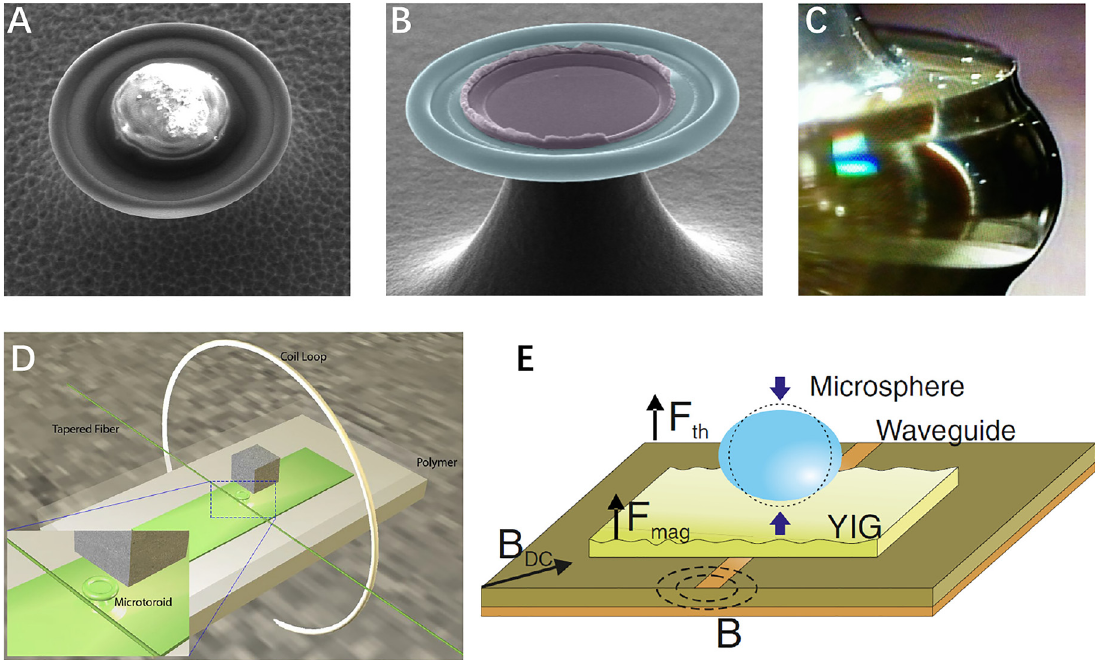
Figure 18: Cavity optomechanical magnetometers. (A) Cavity optomechancial magnetometry using microtoroids with particles of magnetostrictive material Terfenol-D embedded inside [49]. (B) Cavity optomechanical magnetometry using microtoroids with a thin film of Terfenol-D sputter coated inside [47]. (C) Cavity optomechanical magnetometry using a cm-size CaF embedded inside [46]. (D) A magnetometer using a microtoroid with a microsized magnet embedded inside the cavity, capsulated using poly(dimethylsiloxane) (PDMS) [50]. (E) Magnetometry working at hundreds of MHz to a few GHz, assisted by ferromagnetic resonance in a yttrium iron garnet (YIG) film, whose mechanical motion is read out through a microsphere